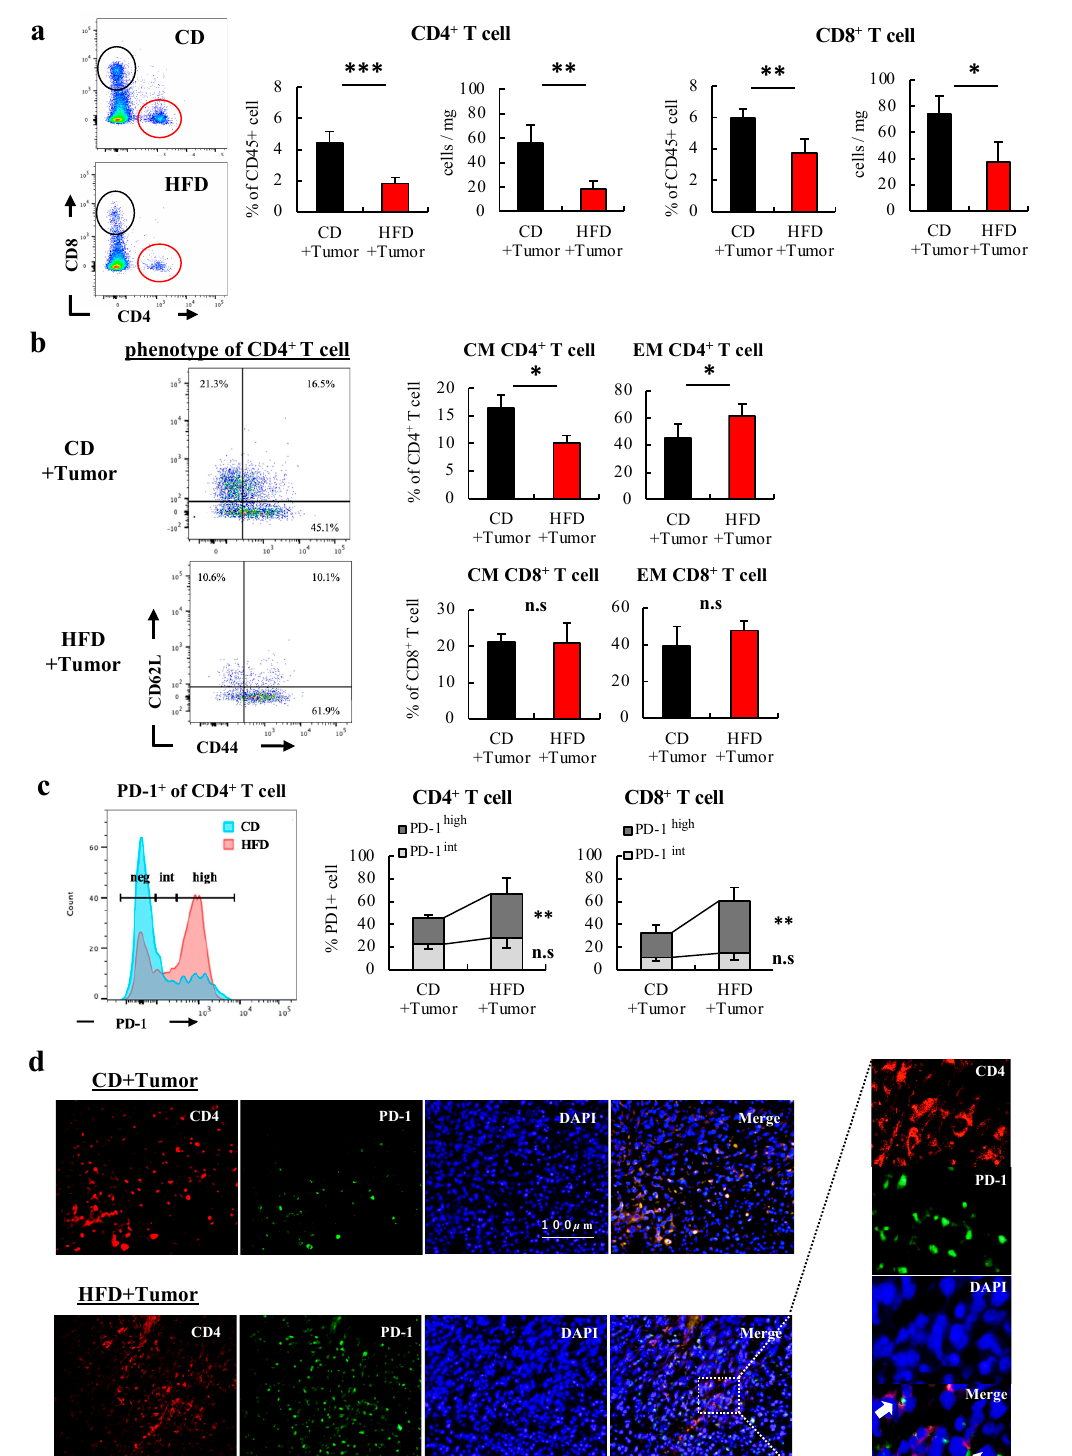
Figure 4. HFD-induced obesity substantially promoted the reduction in number and PD-1 expression of CD4+ T cells in tumors. The CD4+ T cells in the tumors of CD-and HFD-fed mice were analyzed after 3 weeks of tumor inoculation. ( a ) The percentage of CD4+ and CD8+ T cells in CD45+ cells in the tumor and the cell number per mg of tumor were analyzed using flow cytometry. ( b ) The phenotype of T cells in the tumors are shown. A representative figure of phenotype of CD4+ T cell